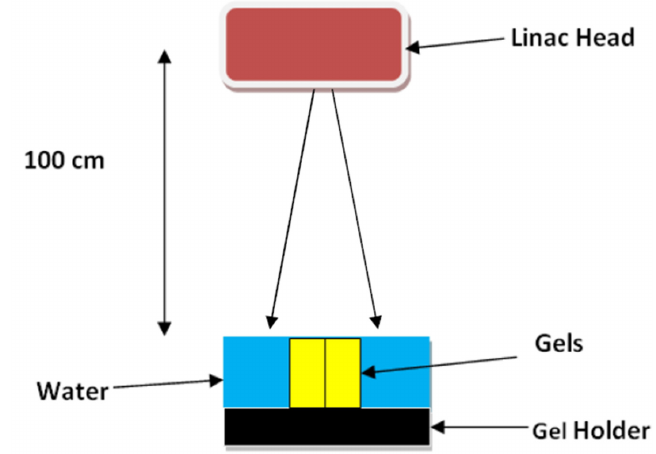
Fig. 1. The schematic illustration of the gel irradiation set up with 18 MV photon